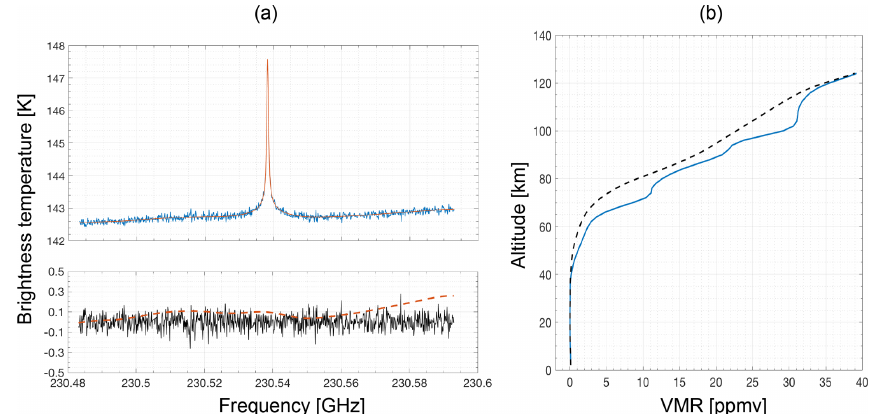
Figure 3. (a) Upper: an example spectrum measured by CORAM on 24 December 2017 between 20:04 and 21:03UTC. The inversion fit to the measurement is shown (red line). Lower: the residual of the measurement and the inversion fit (solid black line). The dashed red line shows the baseline fit for the inversion, which is part of the inversion fit shown in the upper panel (Sect. 2.2.2). (b) The CO profile retrieved from the measurement (solid blue line) and the a priori profile that is used as input to the inversion (dashed black line).